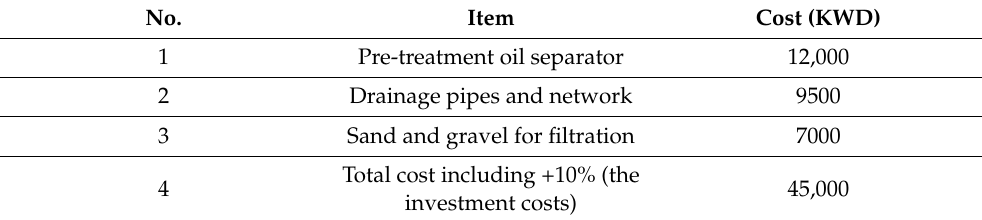
Table 4. The estimated cost of the potential CW.